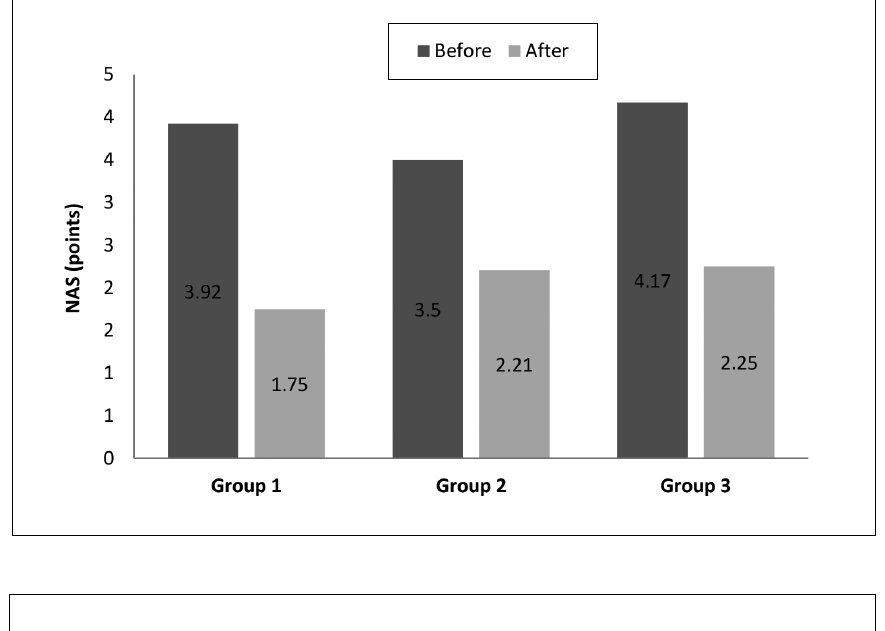
Figure 2. McGill trunk